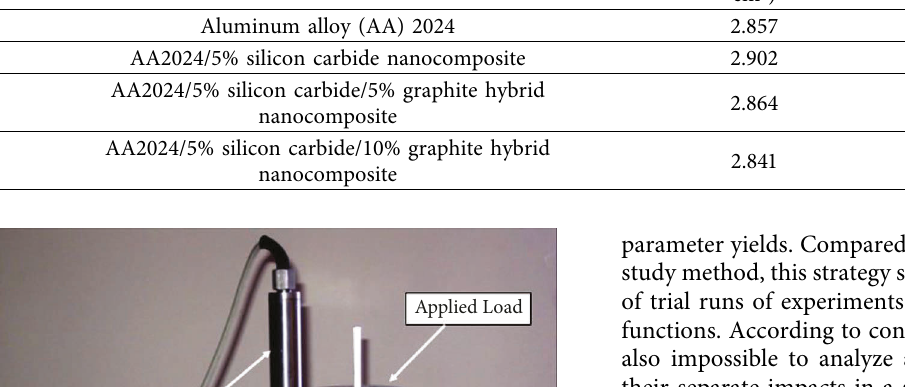
Table 2: Mechanical properties of the fabricated aluminum with silicon carbide and graphite nanocomposites. S. no.